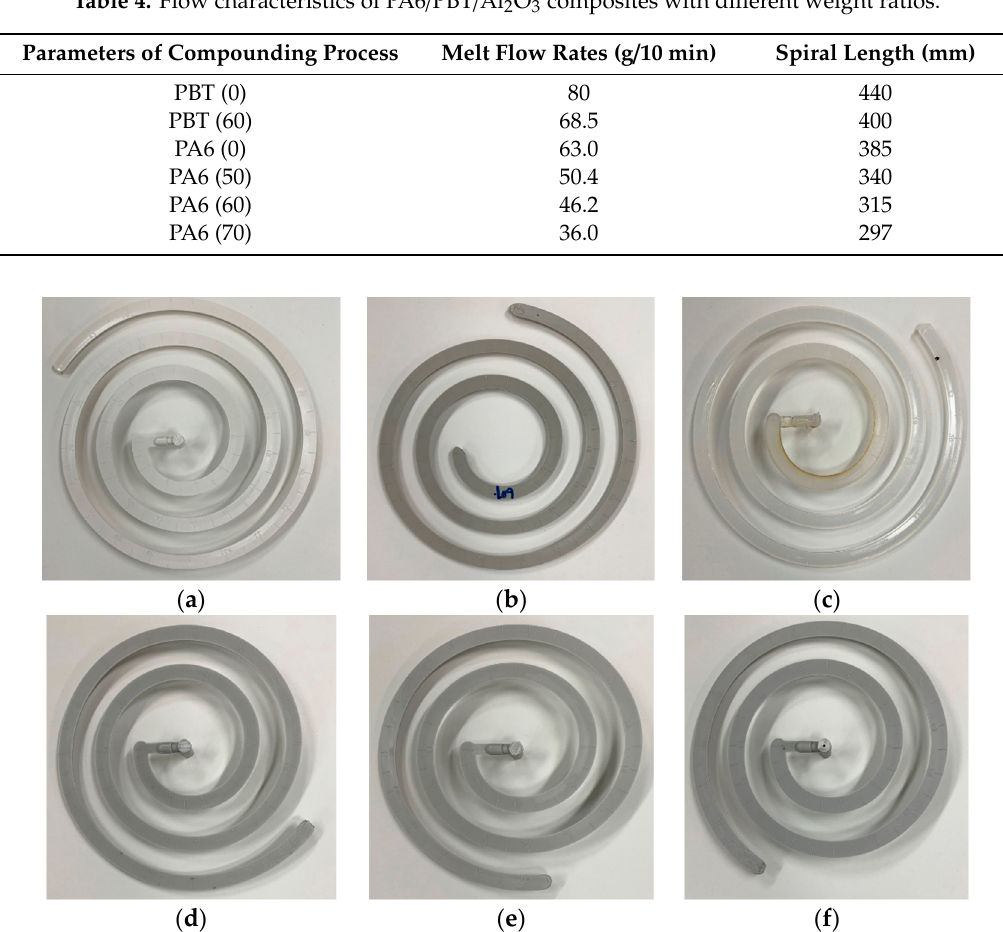
( b ) Figure 2. Injection results of (a) PBT (60) and (b) PA6 (60). 3.4. Thermogravimetric Analysis To study the thermal degradation observed by rheological analysis, PA6 and PBT were mixed with alumina and they were characterized by thermogravimetry (TGA). The results are presented in Figure 3.